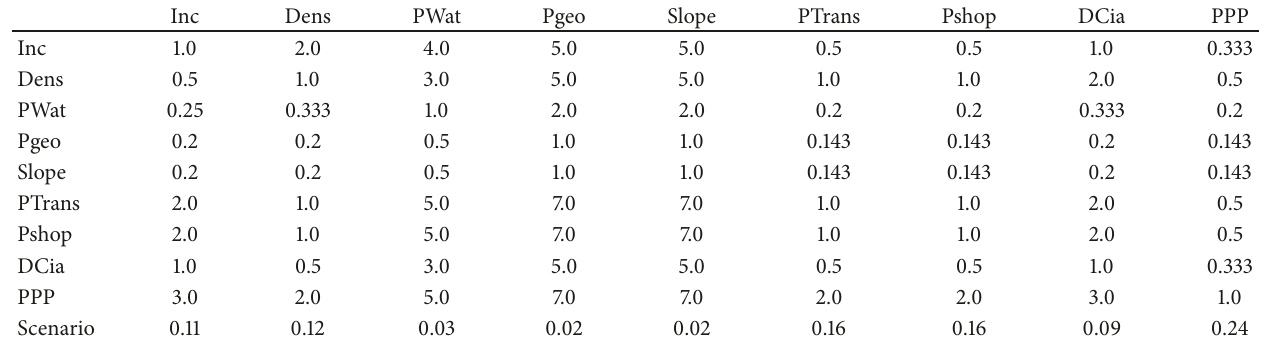
Table 8: Pairwise matrix for L3